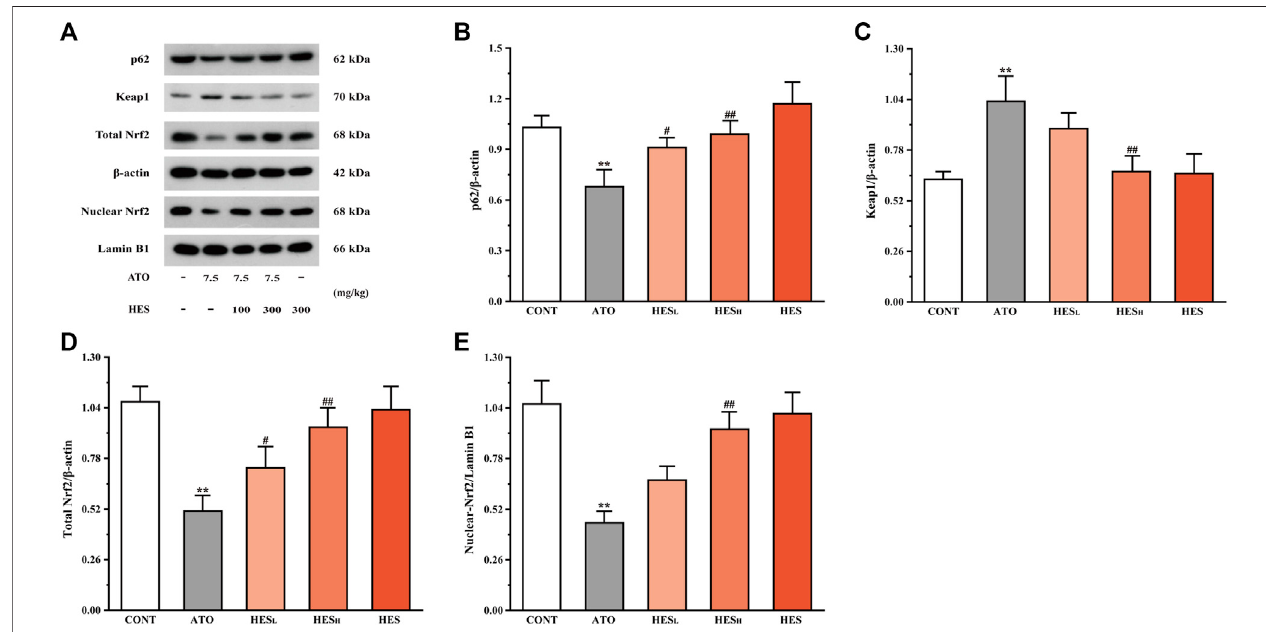
FIGURE 9 | Changes in p62, Keap1, and Nrf2 protein expressions between ATO group and HES groups. Results are expressed as mean ± SD ( n (cid:1) 3). ** p < 0.01, compared to CONT group, # p < 0.05 and ## p < 0.01, compared to ATO group.